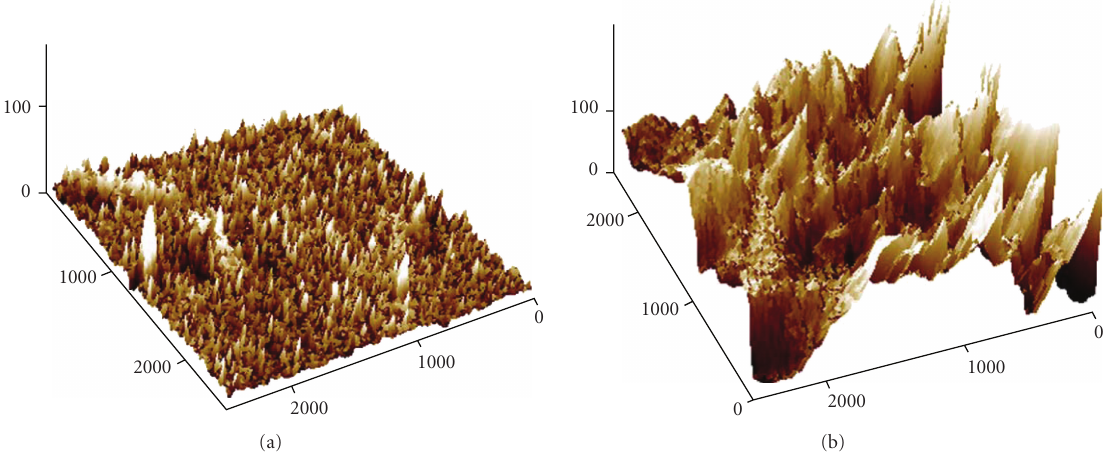
Figure 3: AFM images of acrylic (a) and silicone (b) surfaces with a scan range of 2.5 μ m × 2.5 μ m (air Tapping mode). Axis x and y -nm; axis z - ˚ A.